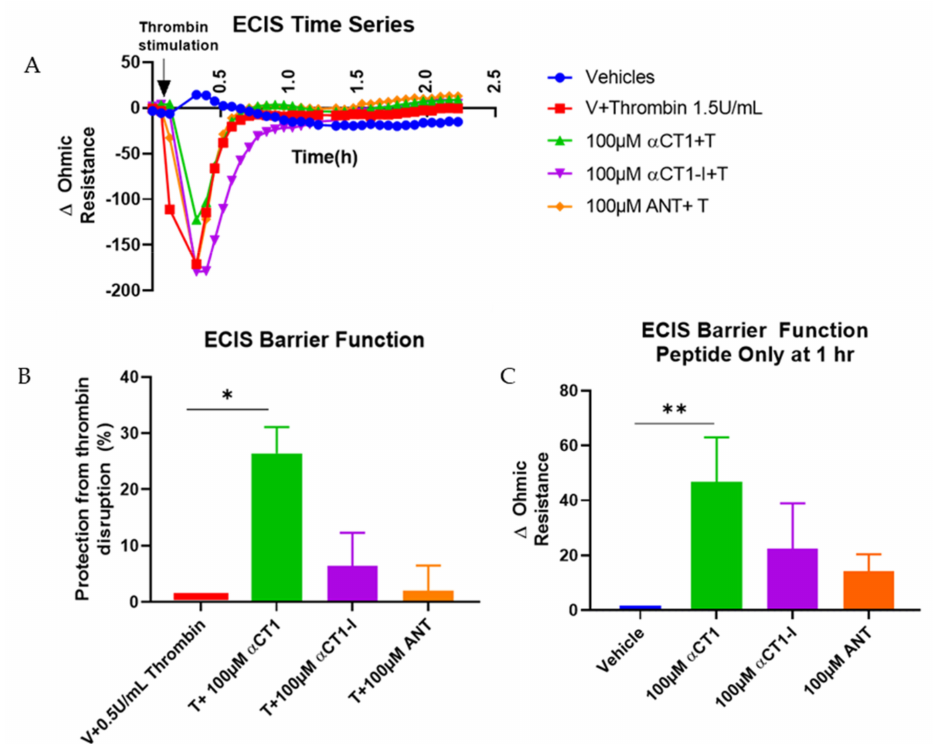
Figure 3. α CT1 requires ZO1 binding competency to protect the endothelial barrier from thrombin- induced disruption measured by Electric Cell-Substrate Impedance Sensing (ECIS) in HMEC-1 cell monolayers. ( A ) Representative ECIS time series showing peptide-induced barrier function changes following thrombin treatment. Each data point represents the change in ohmic resistance from individual treatment baselines, collected at approx. 4 min intervals. ( B ) Approximately 5 min following thrombin addition, peptide-induced barrier function protection was calculated as the percentage of barrier protection from thrombin disruption ( C ) At 1 h peptide incubation, prior to thrombin treatment, the effects of peptides on barrier function were calculated as the change in ohmic resistance compared to vehicle control. ** p < 0.01 * p < 0.05 vs. controls; N = 3–5.